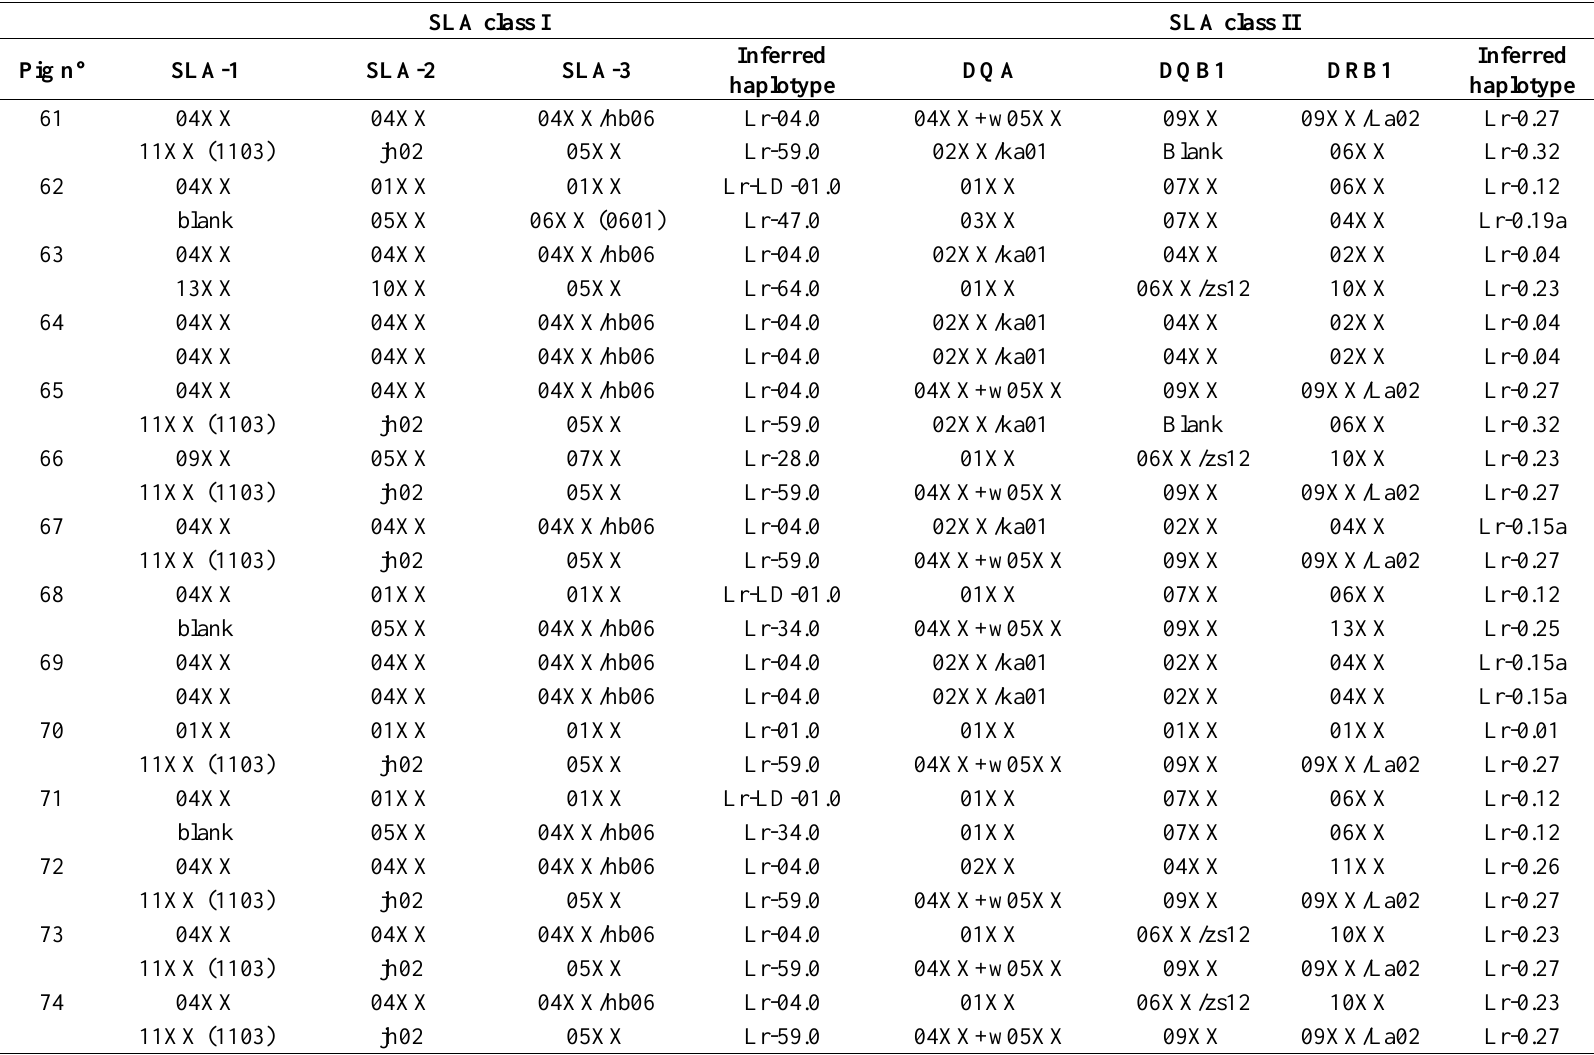
Table 3. Swine leukocyte antigen (SLA) class I and class II low-resolution (Lr) haplotypes identified by PCR-SSP in pigs included in